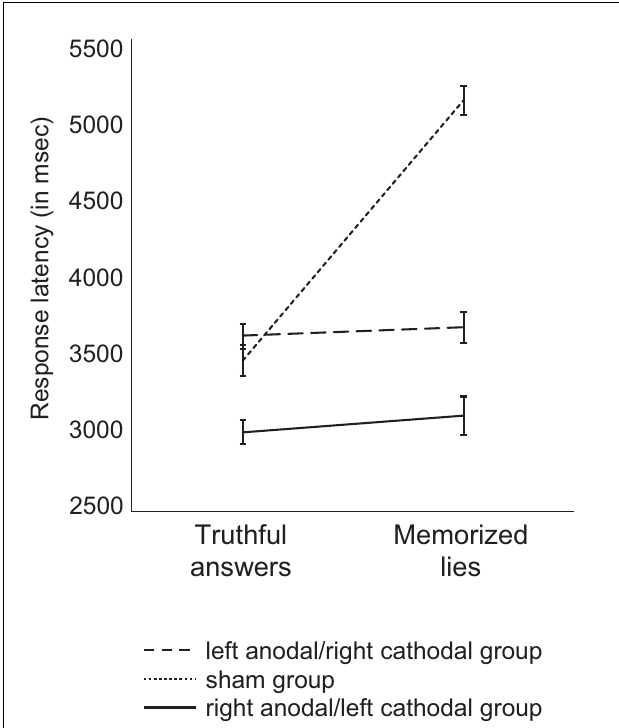
FIGURE 4 |Averaged response latency of truthful answers and memorized lies for each group of participants inTask 2. Participants who received left anodal/rightt cathodal DLPFC stimulation were faster at generating spontaneous lies, showing smaller difference between truthful answers and spontaneous lies (difference of 25ms) than participants who received sham stimulation (difference of 143ms) and right anodal/left cathodal DLPFC stimulation (difference of 80ms). Error bars represent